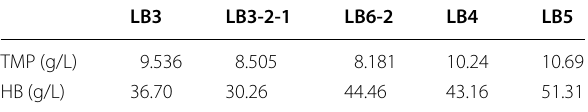
Table 2 The final yield of TTMP and HB of endophytic B.